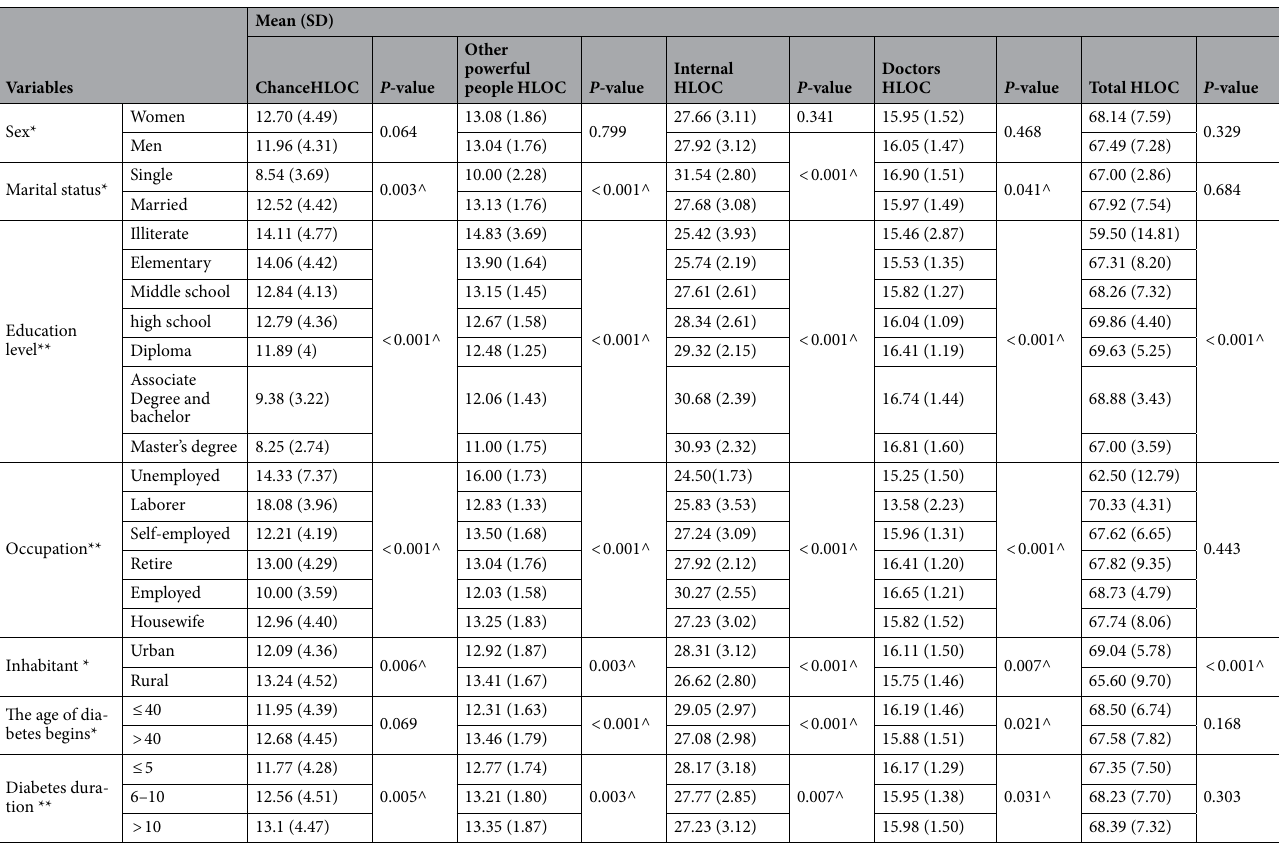
Table 3. Relationship between demographic variables and health locus of control (HLOC). * Independents sample T-test, ** One- Way ANOVA, ^ significance level <